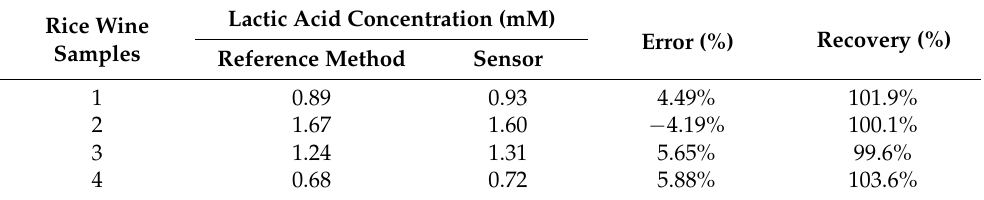
Table 2. Determination of lactic acid in rice wine